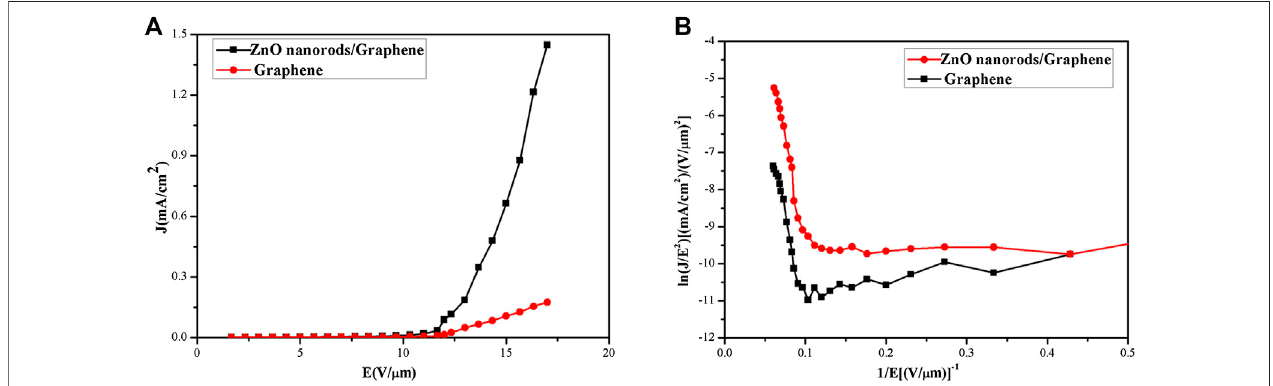
FIGURE 6 | (A) Emission current density vs. electric fi eld curves and (B) F – N plot at different emission cathodes.